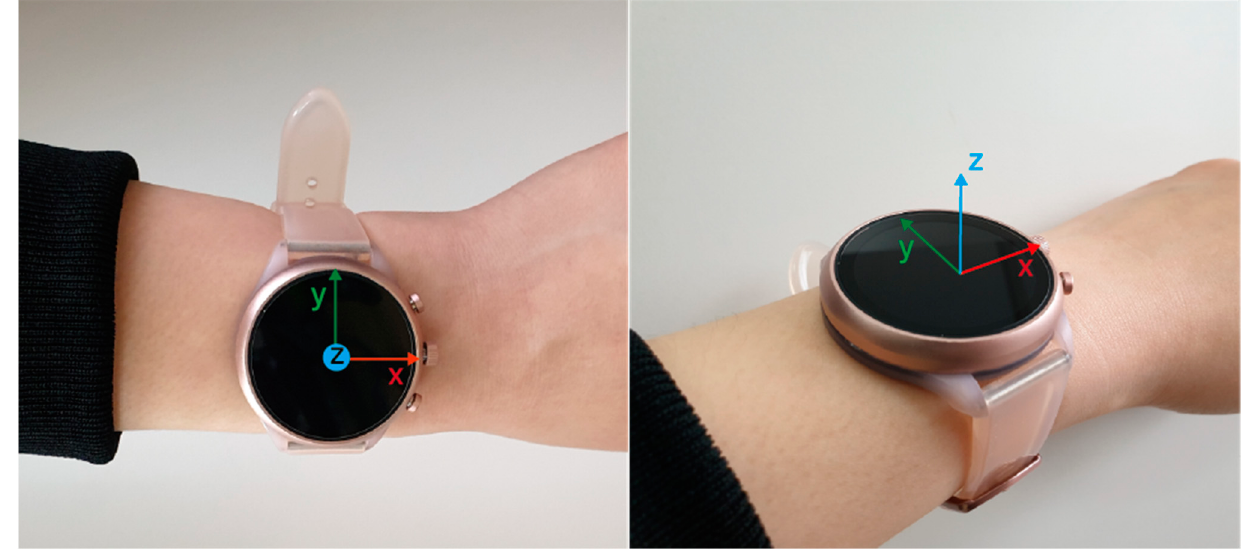
Figure 3. The smartwatch with its axis displayed adopted for the experiment.